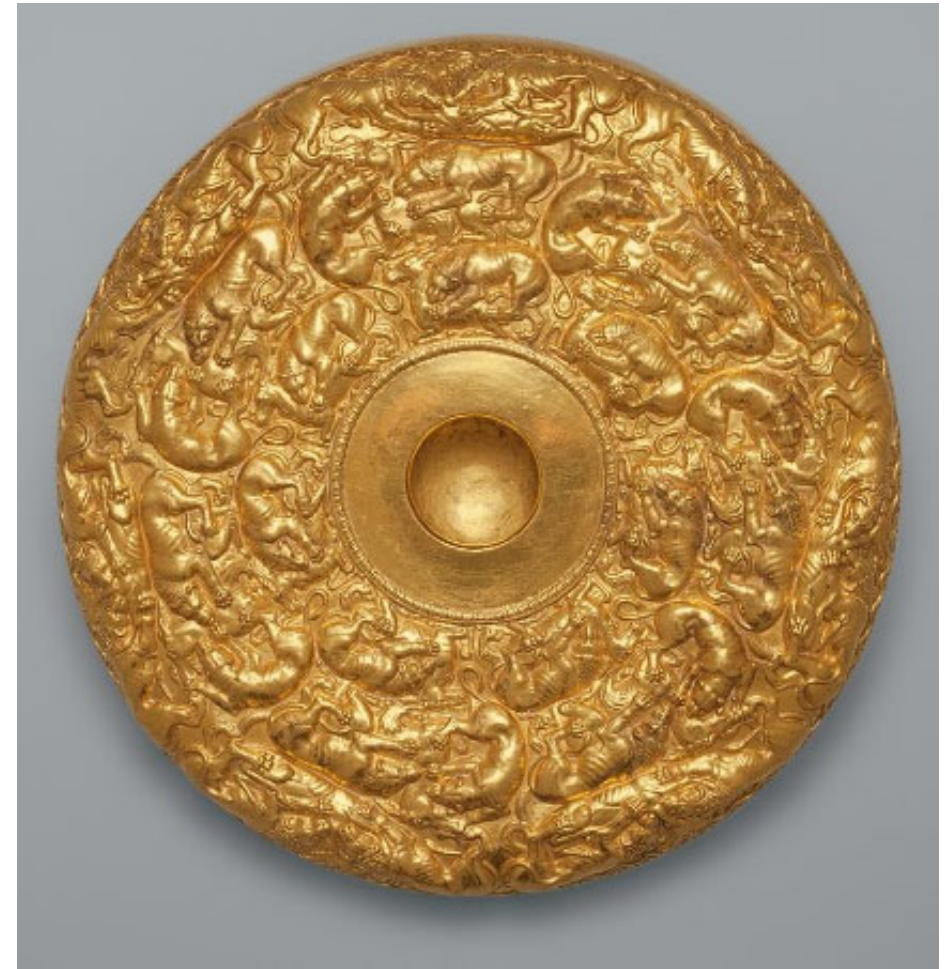
Figure 28. Phiale depicting contest between beasts (SHM inv. no. Дн .1913 ‐ 1/48); chased gold; Solokha Tumulus, Dnepropetrovsk region, Ukraine; late 5th to early 4th century BC. [Image is used from www.hermitagemuseum.org (accessed 9 November 2022), courtesy of the State Hermitage Museum, St. Petersburg, Russia].